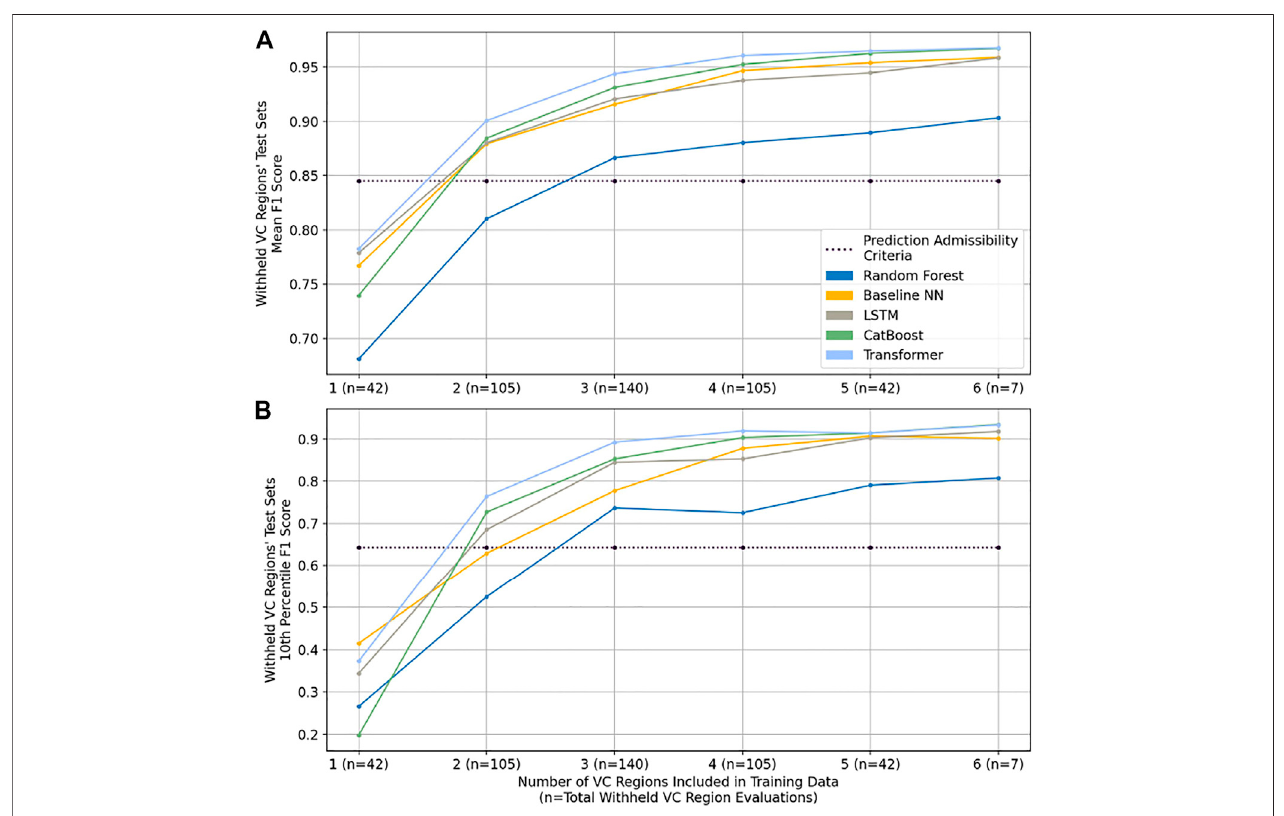
FIGURE 6 | Withheld region test dataset performance for different classi fi er models, organized along the x -axis by the number of regions included during training. (A) presents mean F 1 score over the withheld regions; (B) presents the 10th percentile F 1 score over the withheld regions. Results indicate that the transformer based classi fi er yields the best performance, followed closely by the CatBoost model. F 1 scores from classi fi cation based on the prediction admissibility criteria are presented for